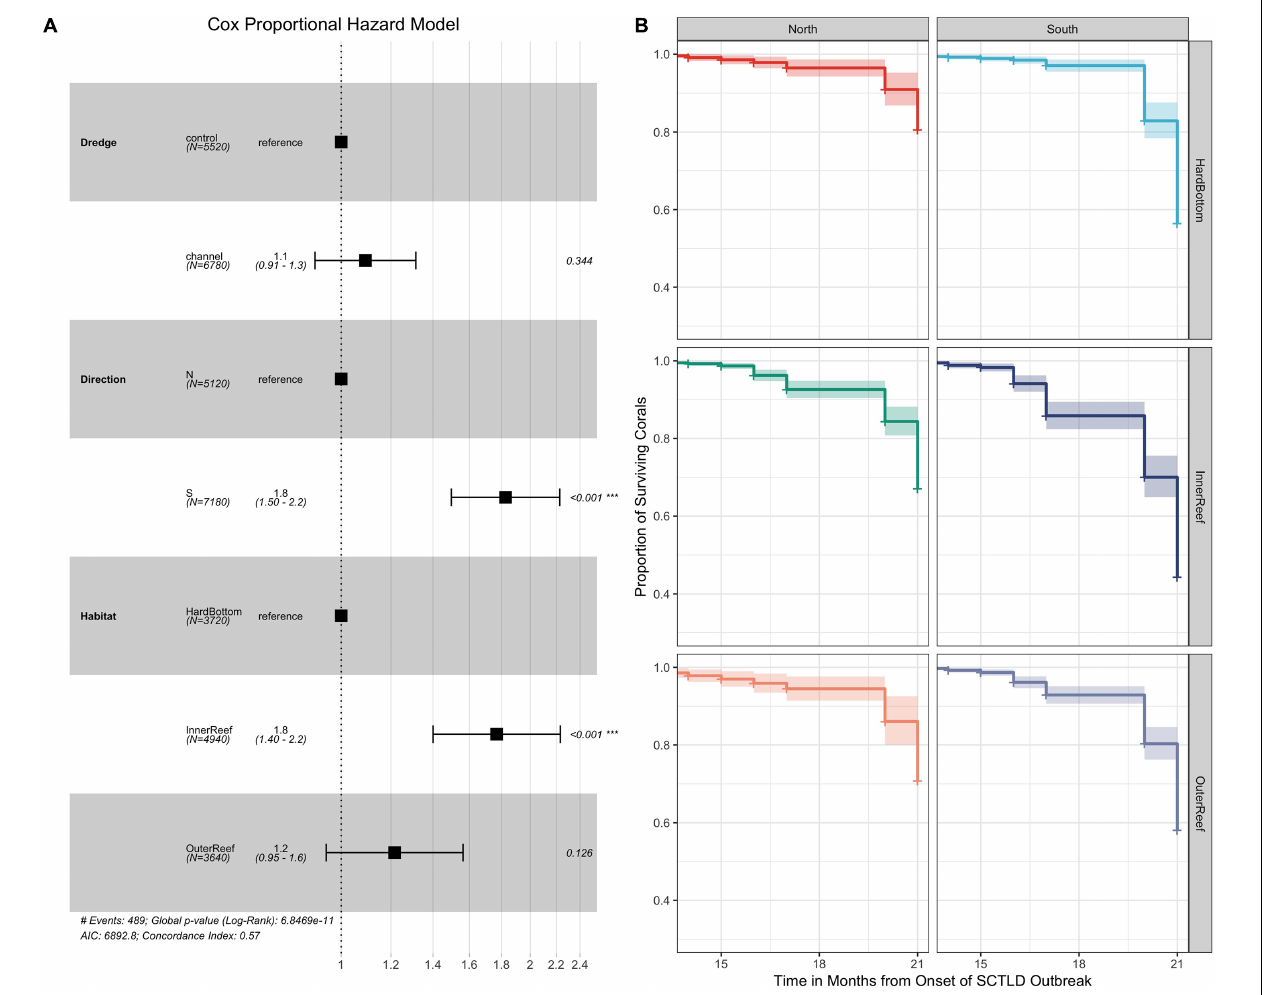
FIGURE 4 | Cox-proportional hazard model (A) comparing the effects of dredge (control vs. channel), habitat (hardbottom vs. inner reef and outer reef), and direction (north vs. south) on coral survival across the 21-month observation period for the full 615 tagged coral dataset along with survival curves (B) plotting the significant main effects of direction and habitat on coral survival. In the Cox-proportional hazard model (A) the median hazard ratios (HR) +/– the standard errors are shown along with the p -values (far right) showing the pairwise comparisons between the reference level and the comparison (e.g., control as the reference for dredging compared to